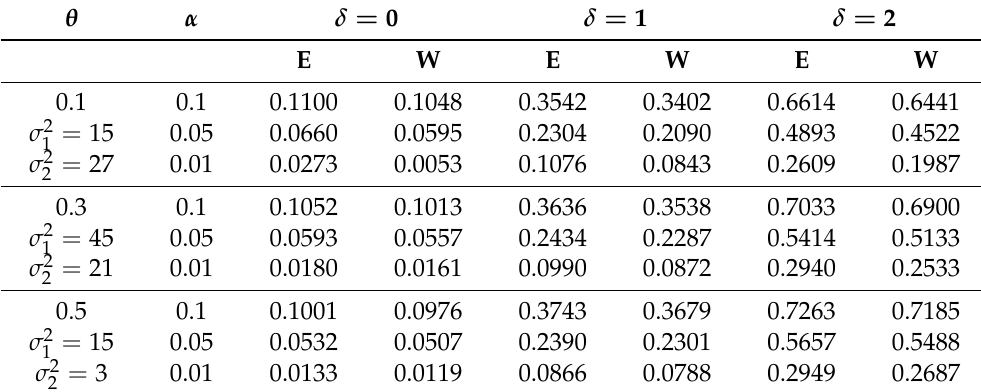
Table 2. Power values for ( n 1 , n 2 ) = ( 15,3 ) .